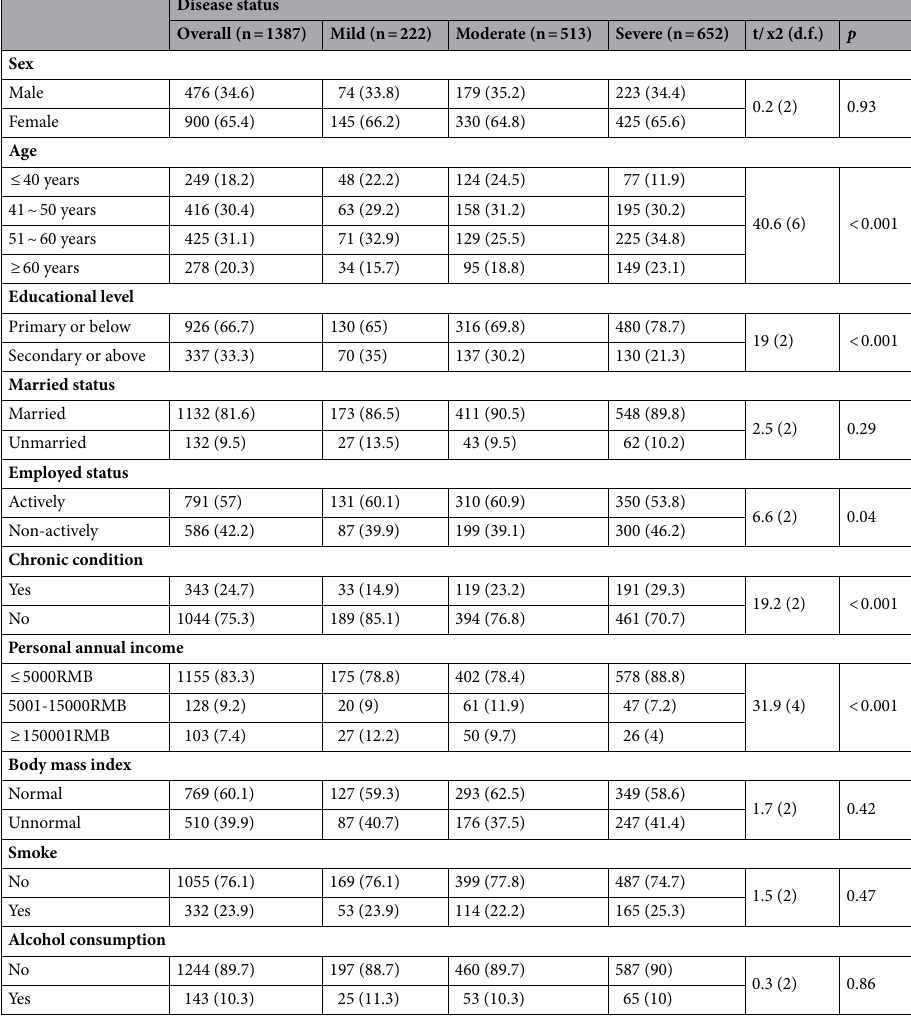
Table 1. General characteristics and stratified by disease severity group at baseline in 2012, n (%) 2012,